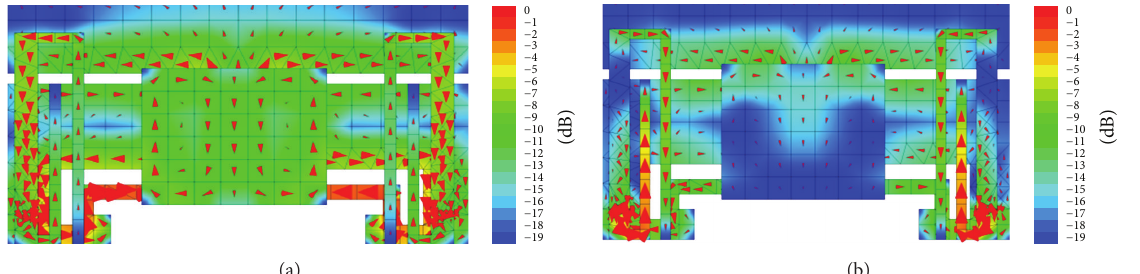
Figure 3: (a) Surface current distribution at 780 MHz of the front side of the antenna. (b) Surface current distribution at 2.350 GHz of the front side of the antenna.